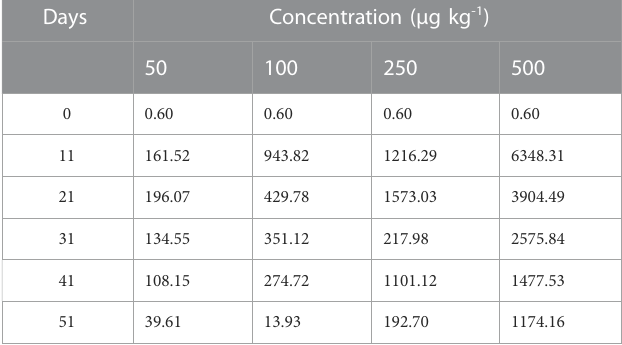
TABLE 4 Recovery percentage (R %) of EB metabolite Emamectin B 1a